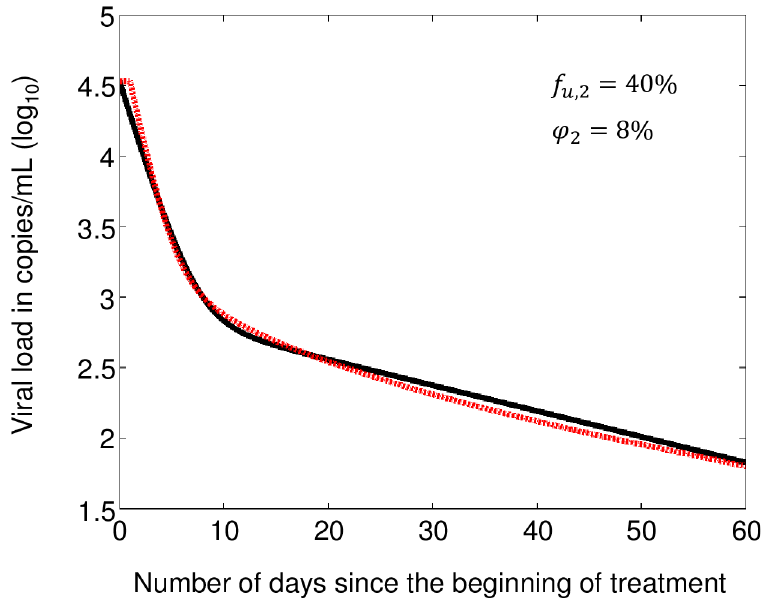
Fig 3. Regression line (black) for the typical patient undertaking a treatment combining efavirenz, tenofovir DF and emtricitabine, model fit (red), and associated f u , 2 and φ 2 values. f u , 2 is the average fraction of total infection events not affected by the drugs and φ 2 is the fraction of maximum plasma viral load. Both parameters refer to the drug-limited compartment. Regression curve based on data from Karris et al.[26].